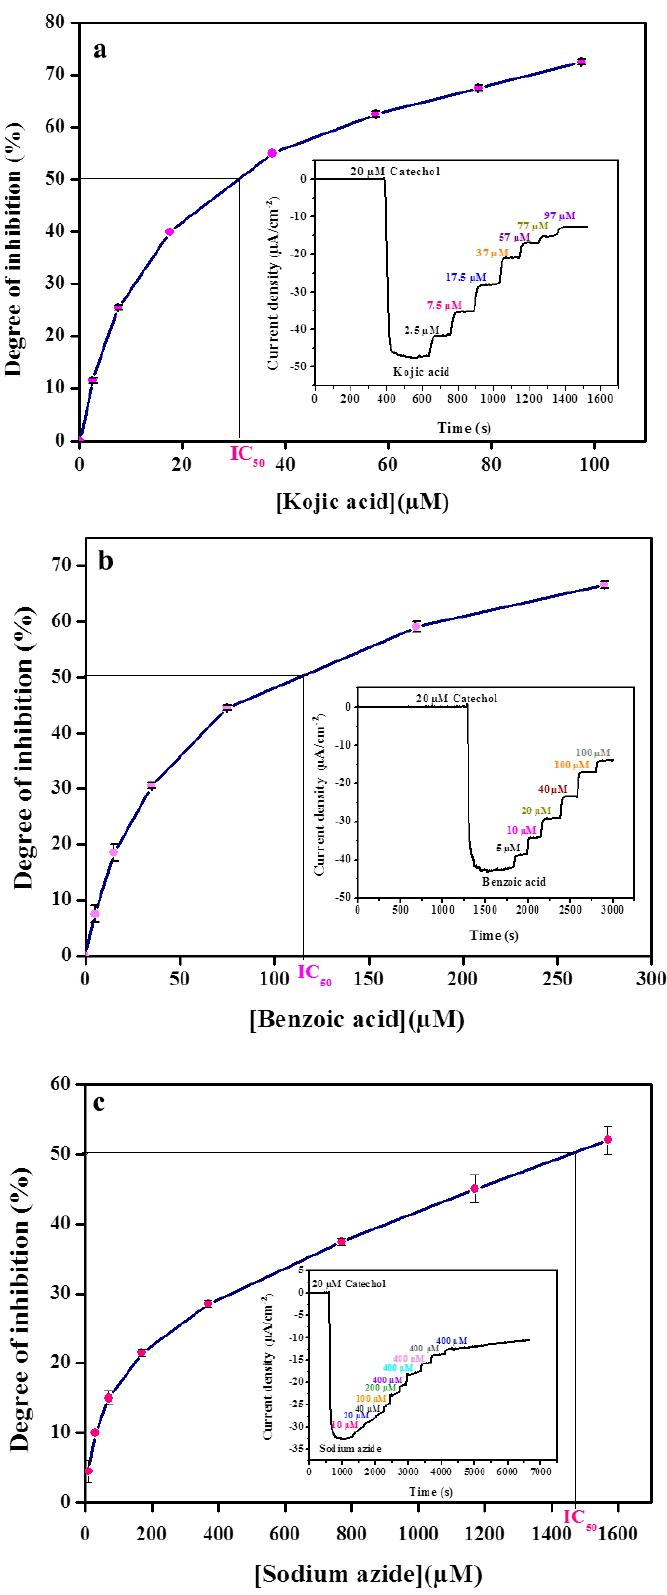
Figure 3. Calibration curve of ( a ) kojic acid, ( b ) benzoic acid, ( c ) sodium azide obtained with the tyrosinase modified carbon black paste in the presence of 20 µM catechol. Inset shows amperometric biosensor response recorded in 0.1 M phosphate buffer, pH 6.8. The applied potential − 0.15 V vs. Ag/AgCl. Data are mean ± SD, n = 3.